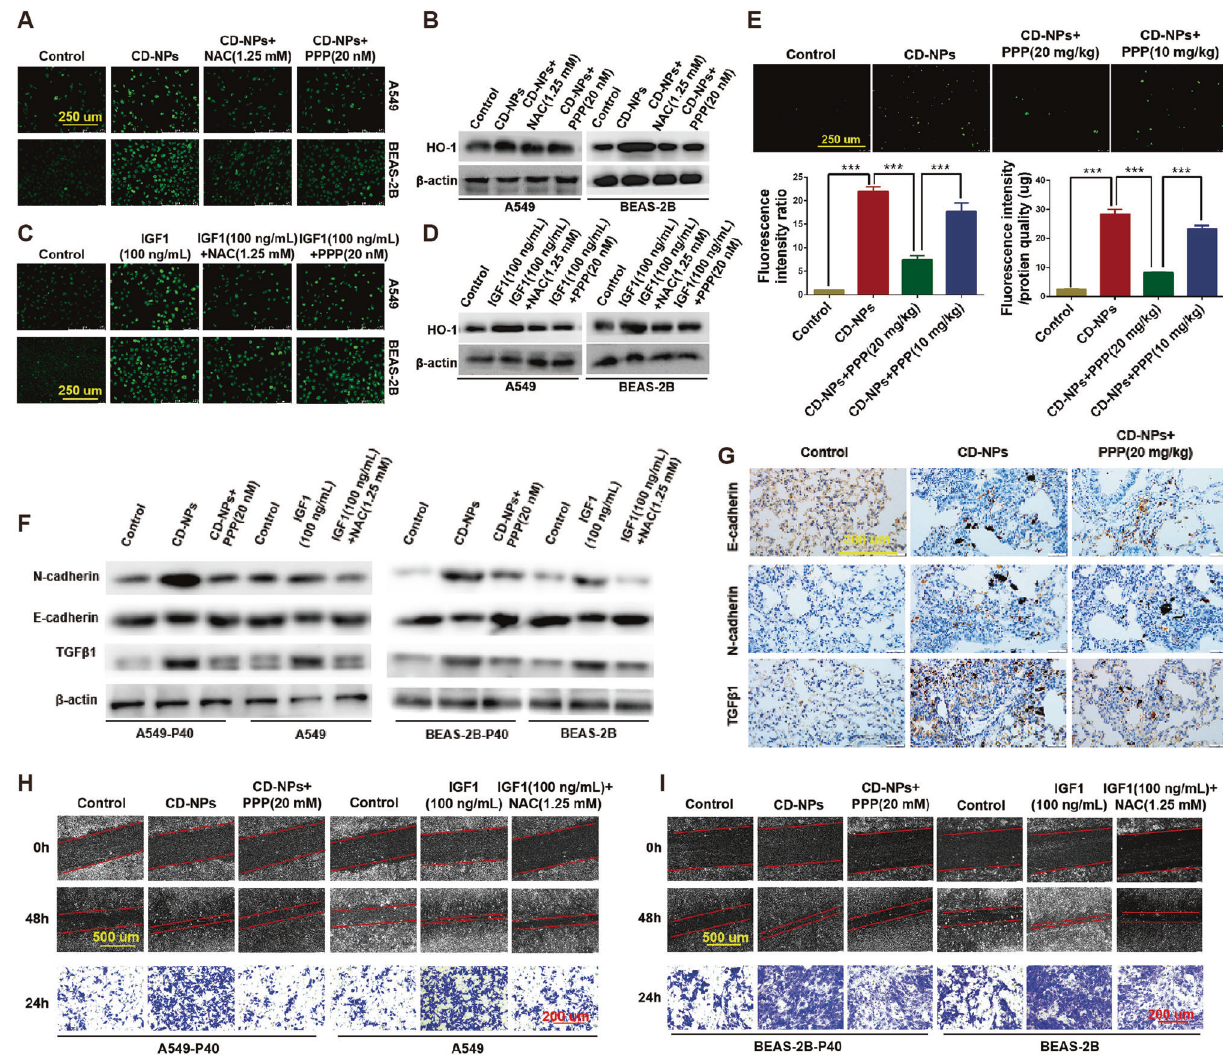
Fig. 4 Activation of IGF1/IGF1R signaling mediates EMT in in vitro and in vivo models by promoting the generation of ROS. A , C ROS levels were detected by ROS fl uorescent probe DCFH-DA in vitro. B , D The expression level of HO-1 was detected by western blot. E ROS levels were detected by ROS fl uorescent probe DCFH-DA in vivo. Data were expressed as the mean ± SD, n = 3. *** P < 0.001. F , G The expression levels of EMT marker molecules (N-cadherin, E-cadherin and TGF β 1) was detected by western blot and immunohistochemistry. H , I The migration and invasion abilities of alveolar epithelial cells were detected by scratch healing assay and transwell pre- fi brosis model cells and animal lung tissue; recombinant human IGF1 could induce EMT in AECs; and inhibition of p-IGF1R/ IGF1R levels and ROS generation could inhibit EMT. Taken together, the above results suggest that activation of IGF1/IGF1R signaling mediates EMT in in vitro and in vivo models by promoting the generation of ROS.